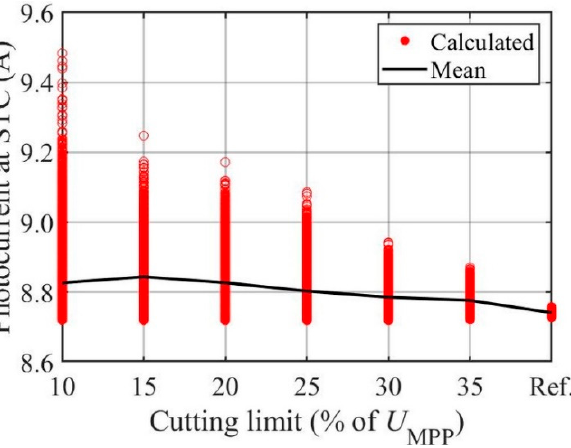
Figure 12. Fitted photocurrent values converted to STCs during the 40 min measurement period as a function of the cutting limit based on the MPP voltage.